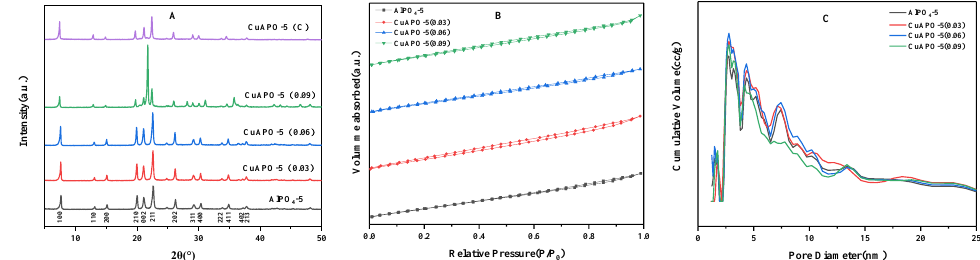
Figure 1. ( A ): XRD spectra, ( B ): N 2 adsorption – desorption isotherms, ( C ): DFT pore size distribu- of AlPO 4 -5 and CuAPO-5 tion of AlPO 4 -5 and CuAPO-5 catalysts.